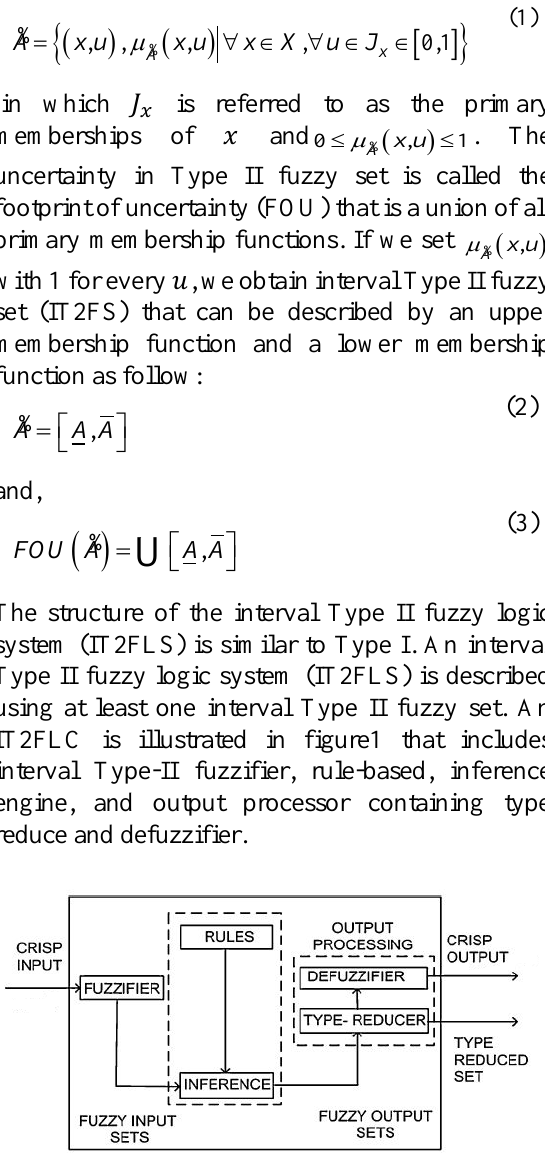
Figure 1. Block diagram of